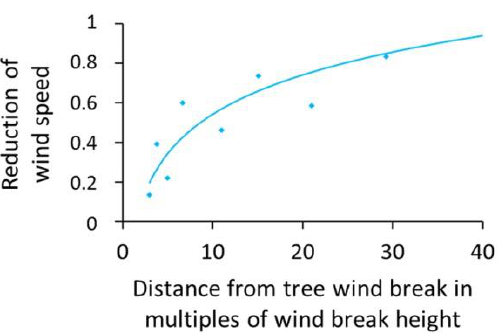
Figure 10. Radiation of open field conditions (Rs open field ) versus radiation (Rs wind break ) leeward of the single row tree wind break at the following distances from the tree wind break: 0.5 * H (in subgraph A ) and 2 * H (in subgraph B ). Distances are expressed in multiples of wind break tree height (H). Measurement time was from 19 April to 3 May. Table 4. Changes of temperature (T [°C]), air humidity (RH), and solar radiation (Rs [MJ/d*m²]) under impact of tree wind breaks. H refers to the height of the tree wind break. T min , T max , RH min , and RH max refer to daily temperature and humidity minima and maxima, respectively, as used for the ETo calculations following the procedure of [20]. Rs is the daily sum of solar radiation. T min wind break , T max wind break , RH min wind break , RH max wind break and Rs wind break refer to daily temperature and humidity minima and maxima, respectively, as well as the solar radiation as changed by the impact of tree wind breaks. Tree Wind Break Type Single Row Tree Wind Break Multiple Row Tree Wind Break with Understory Vegetation Minimum temperature Closer than 1.5 × H T min wind break = 1.0007 × T min + 0.4506